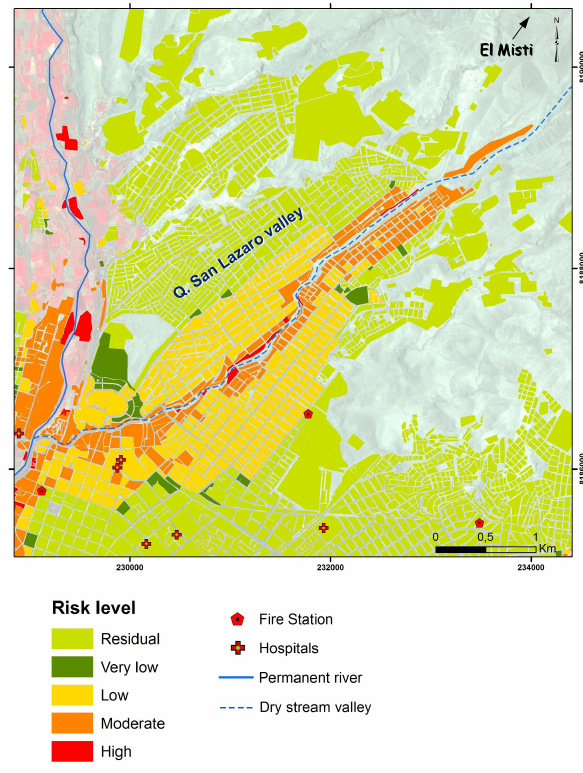
Fig. 14. Areas prone to lahar risk in the Quebrada San Lazaro; this map is an enlargement of Fig.